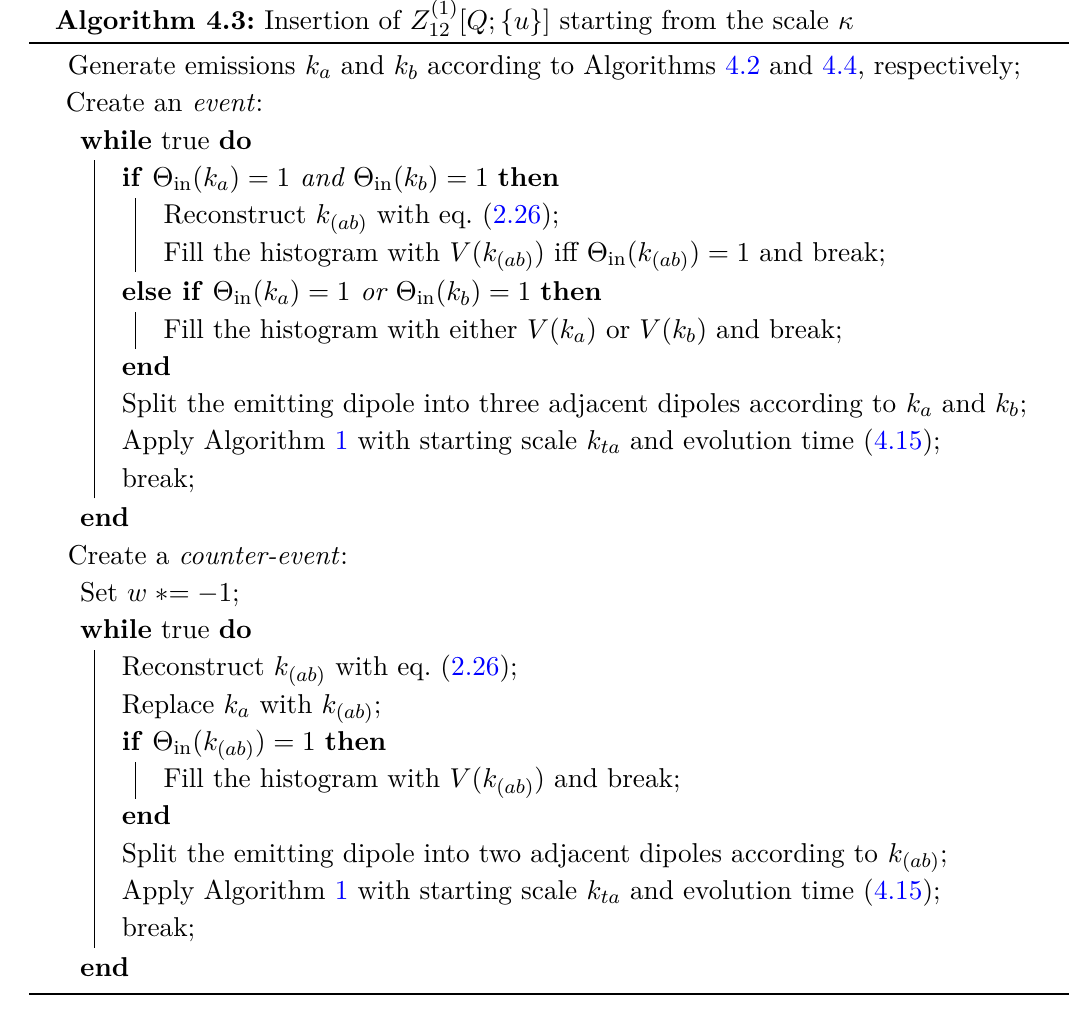
Algorithm 4.3: Insertion of Z (1) Generate emissions k